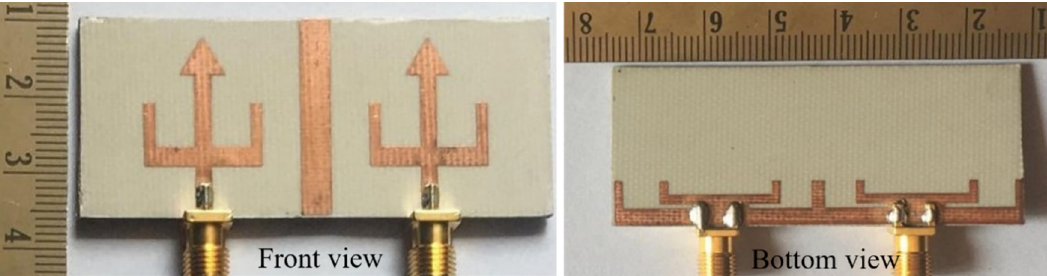
Figure 15. Top and bottom view of fabricated antenna [49]. To obtain the dual-band characteristics, an arrow-shaped strip is placed between the U-shaped patch with two L-shaped slots on the GP. The dual frequency bands cover the frequency range from 2.99 to 3.61 GHz (lower band) and 4.53 to 4.92 GHz (higher band) with isolation ≤ − 25 dB and ≤− 16 dB, respectively (Figure 16). This MIMO antenna effectively covers the 5G and sub 6G n77/n78/n79 spectrum.